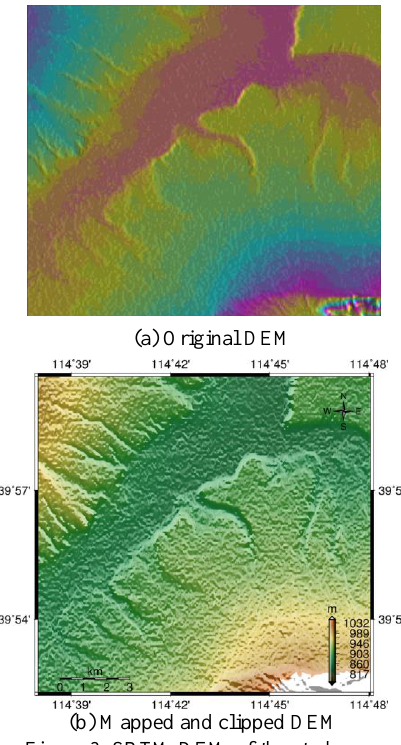
Figure 2. Study area and image range.